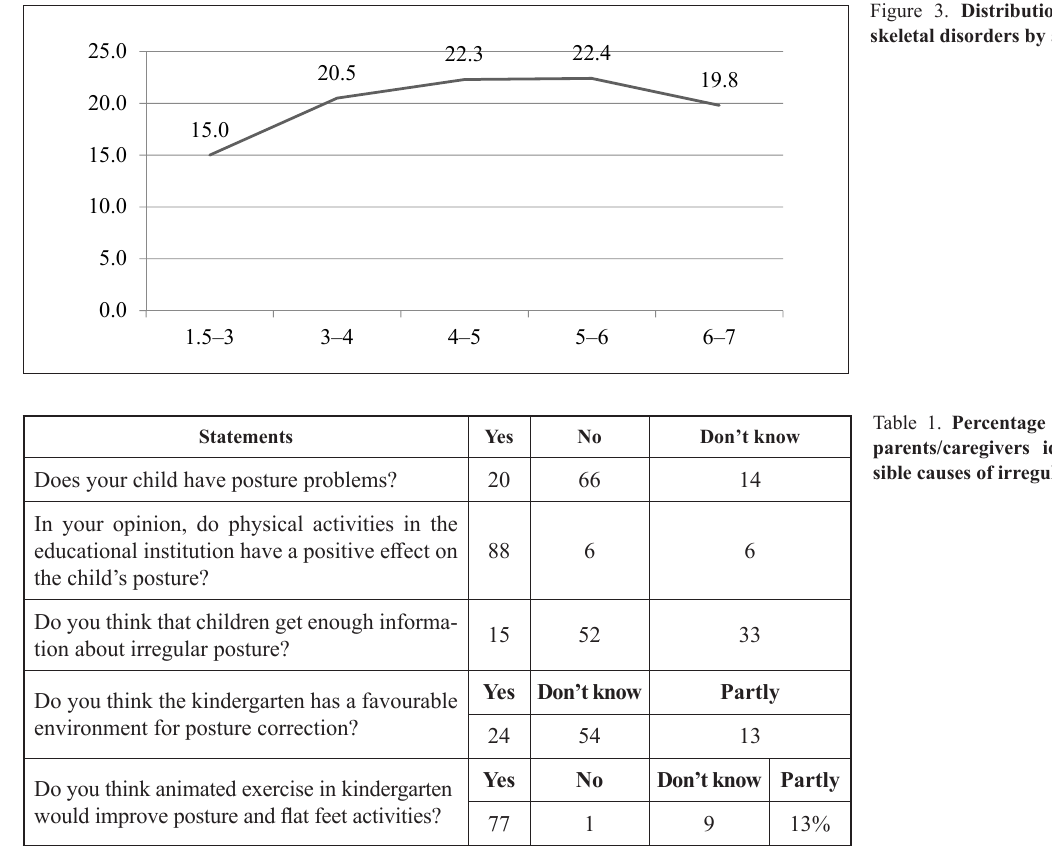
Figure 3. Distribution of musculo-